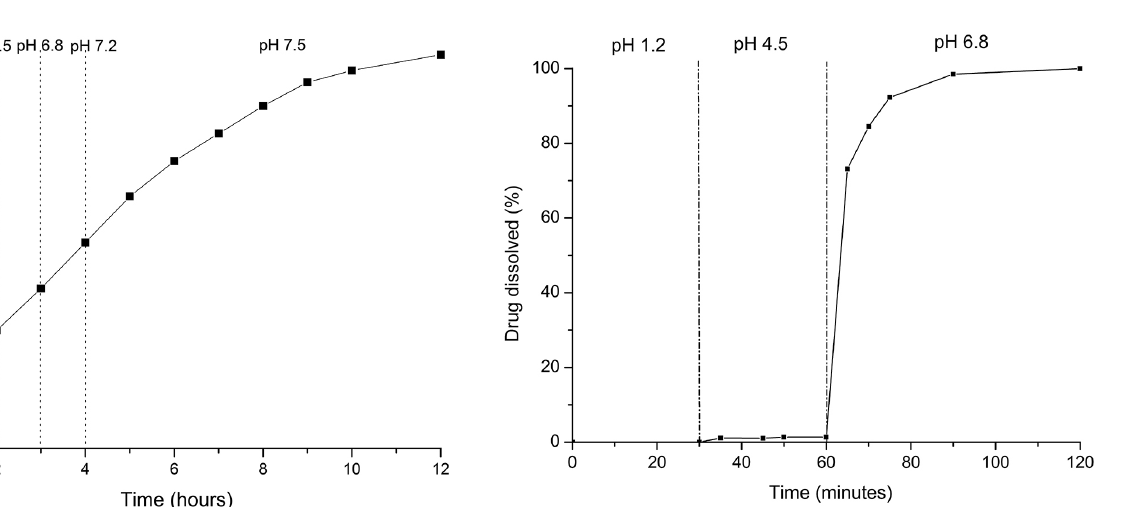
FIGURE 5 - Hypothetical dissolution profile of a gastro-resistant formulation using USP apparatus 1 in a pH 6.8 buffer.